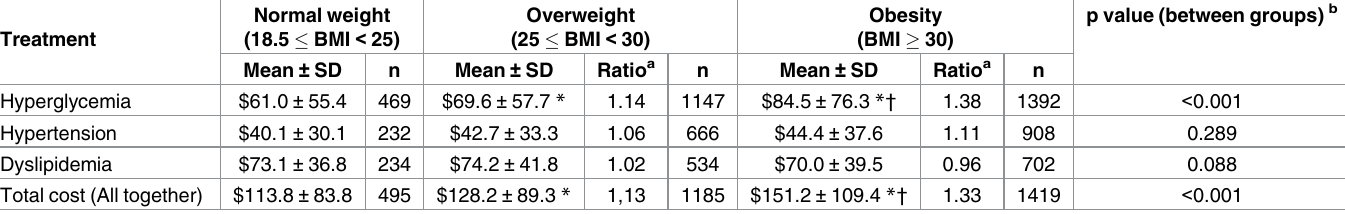
associated with gender, duration of diabetes, BMI and LDL-cholesterol values, dyslipidemia, T2D complications and type of drugs employed. Discussion Our data show that increase in BMI is associated with a parallel growth in overall drugs treat- ment cost of hyperglycemia and its associated cardiovascular risk factors. This effect was observed despite comparable values for FBG/HbA1c and blood pressure found in each BMI classified group. However, impaired serum lipid profile, characterized by significantly high tri- glyceride level, was recorded mainly in the overweight/obese groups. Based on these results and the fact that treatment costs were expressed per capita , we could assume that people with higher BMI required larger quantities of drugs to attain a given blood glucose treatment target. Table 3. Monthly cost of drug treatment per capita by risk factor and BMI categories .